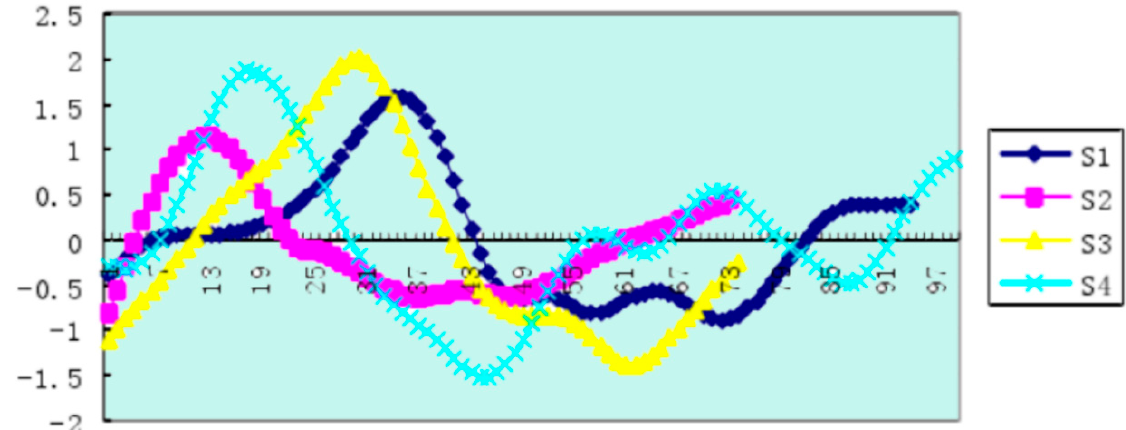
Figure 7. Angular velocity change curve of the sample athlete’s trunk links. The abscissa is the time of a swimming cycle, and the ordinate is in radians per second.